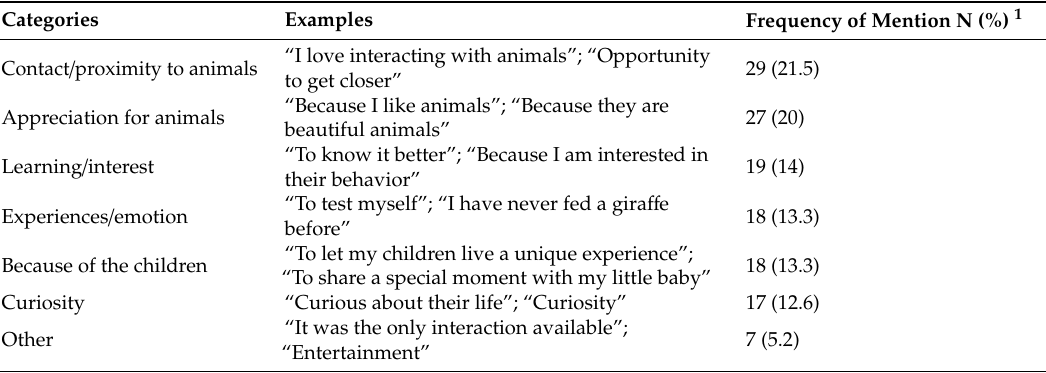
Table A9. Frequency of mention of the categories and examples of individual motivation identified when respondents ( N = 67) were asked why they decided to join the “gira ff e feeding” interaction (in order of